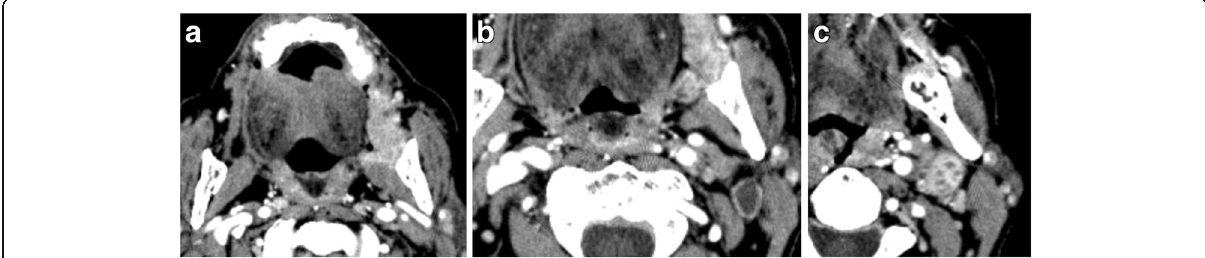
Fig. 1 A case of retro-molar molar trigone squamous cell carcinoma (yellow arrow in “ a ” ), with associated metastatic necrotic nodes at level II ( b ), showing thin peripheral margin and is not termed cystic in our study. This shows thin rim with regular margin. Other nodes are more solid with tiny necrotic foci and moderate hyperenhancement ( c ). The features are all in favor of squamous cell carcinoma